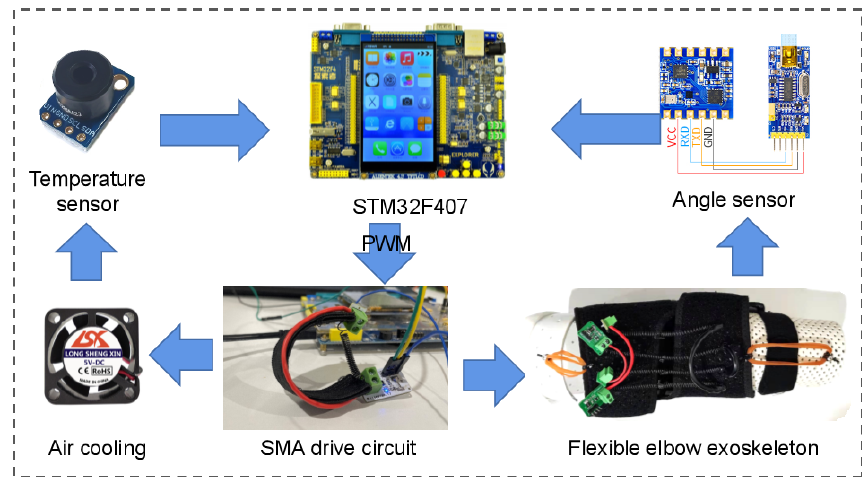
Figure 7. Control system of the elbow exoskeleton.